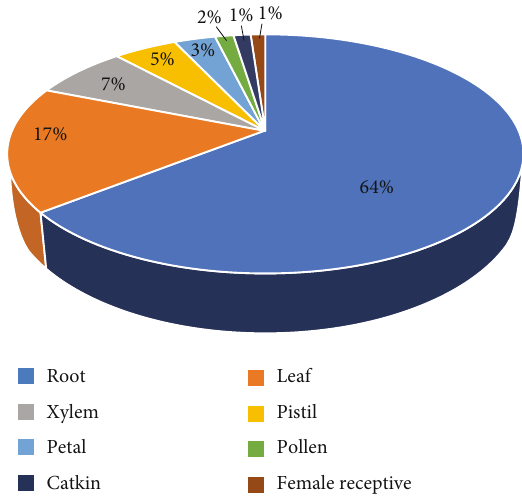
Figure 3: In silico transcriptomic expression pattern of SpuSKOR in di ff erent tissues/organs of purple osier. The expression levels (RPKM) of SpuSKOR were directly downloaded from Phytozome Genomic Resources (purple osier).